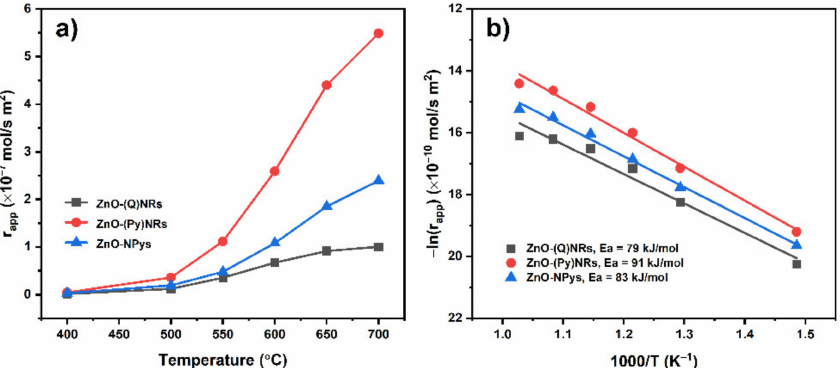
Figure 12. ( a ) Surface area-normalized apparent reaction rates (r app ) for ZnO-nanomaterials deter- mined at various temperatures and ( b ) Arrhenius plot based on r app values showing the calculated activation energies (E a ) of ZnO-based catalysts.